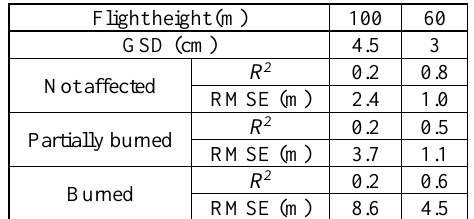
Table 2. Mean NDVI and height values for low, medium and high classes of the tree-classes NDVI, in each performed flight.